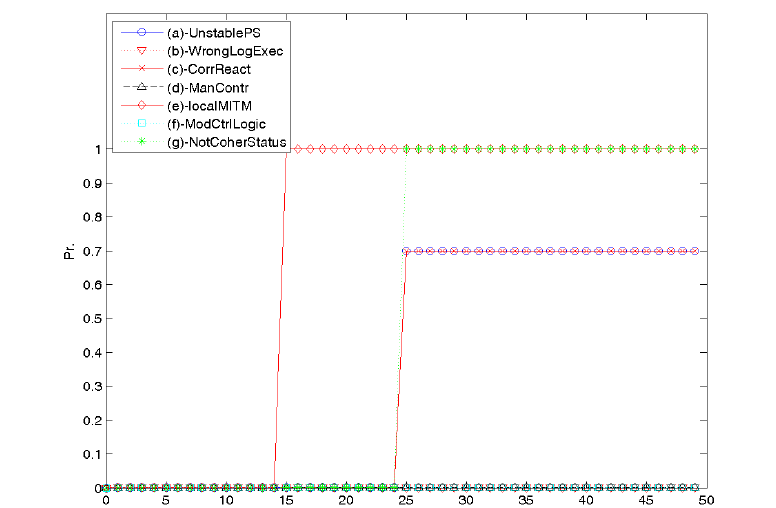
Figure 8. Task: monitoring. All analytics register no adversarial activity except for SERVICE BINARY MODIFICATIONS and QUICK EXECUTION OF A SERIES OF SUSPICIOUS COMMANDS starting at time t = 15, and DATA COHERENCE CHECK — DEVICE and MESSAGE FREQUENCY starting from time t = 25. The technique (e) (resp. the event (g)) has probability 1 starting at t = 15 (resp. t = 25). At t = 25 both (a) and (c) jump to probability 0.7. For (b,d,f) the probabilities of success remain negligible.